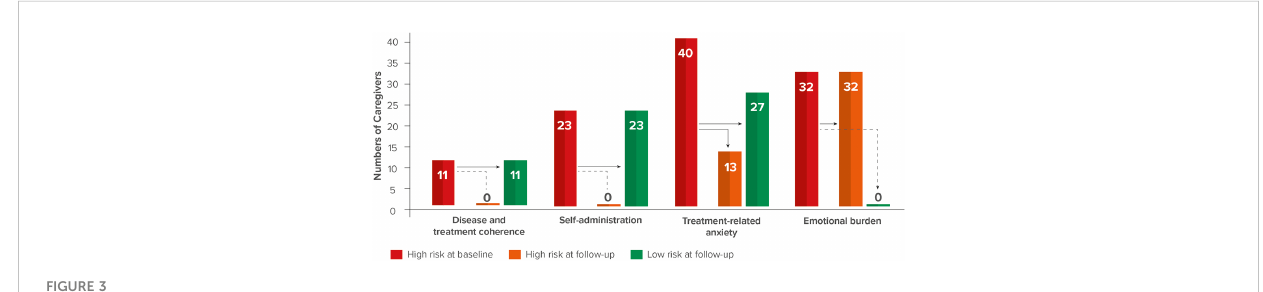
FIGURE 3 Change from high-risk to low-risk group following TUITEK ® PSP.